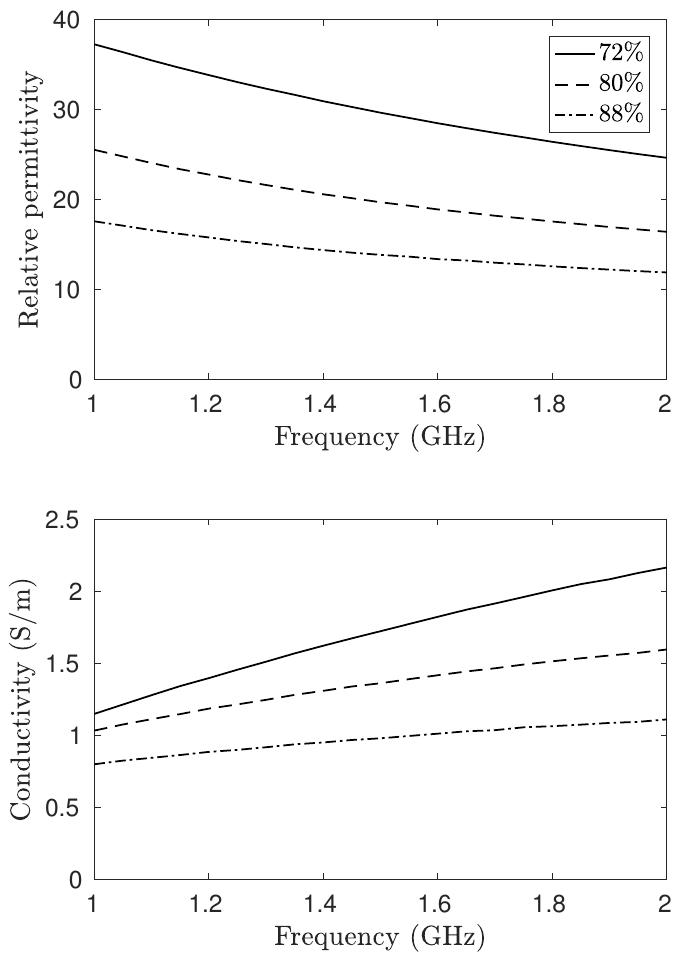
Figure 4. Dielectric properties of the associated glycerin–water mixtures as function of the frequency. This should be compared to the plastic having a permittivity of roughly 3 at